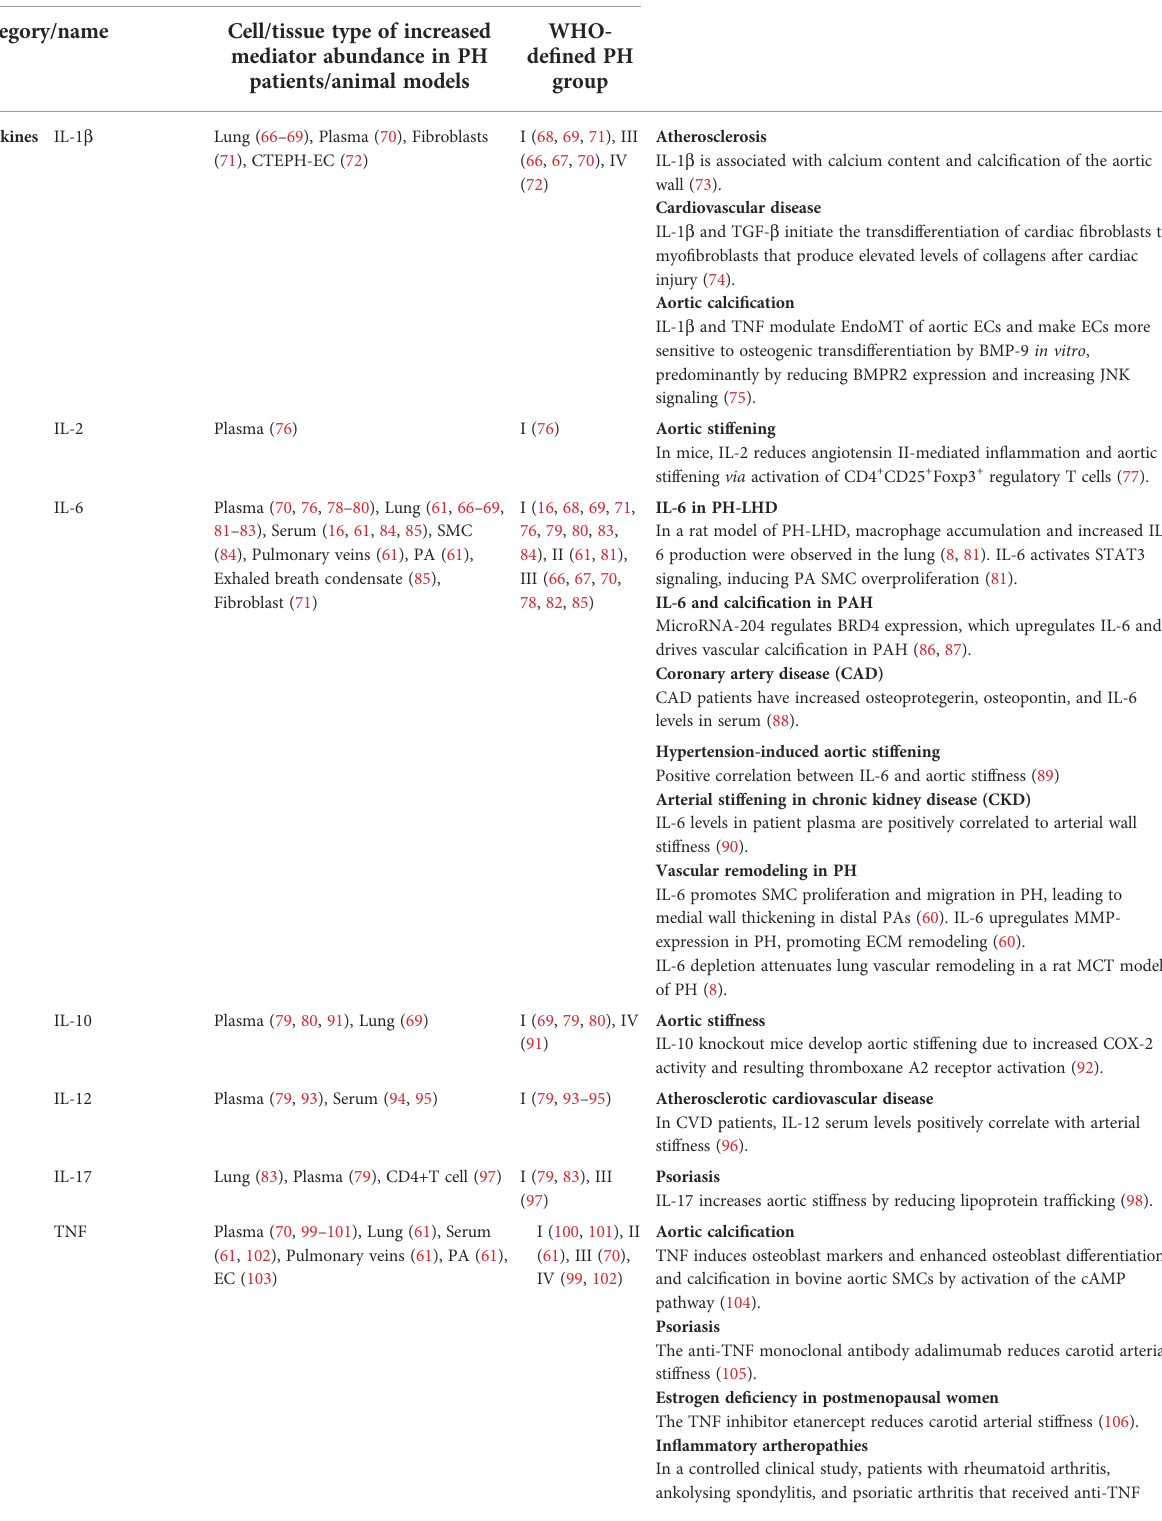
TABLE 1 In fl ammatory mediators associated with vascular stiffening. Cytokines, immune cells, and adhesion molecules in